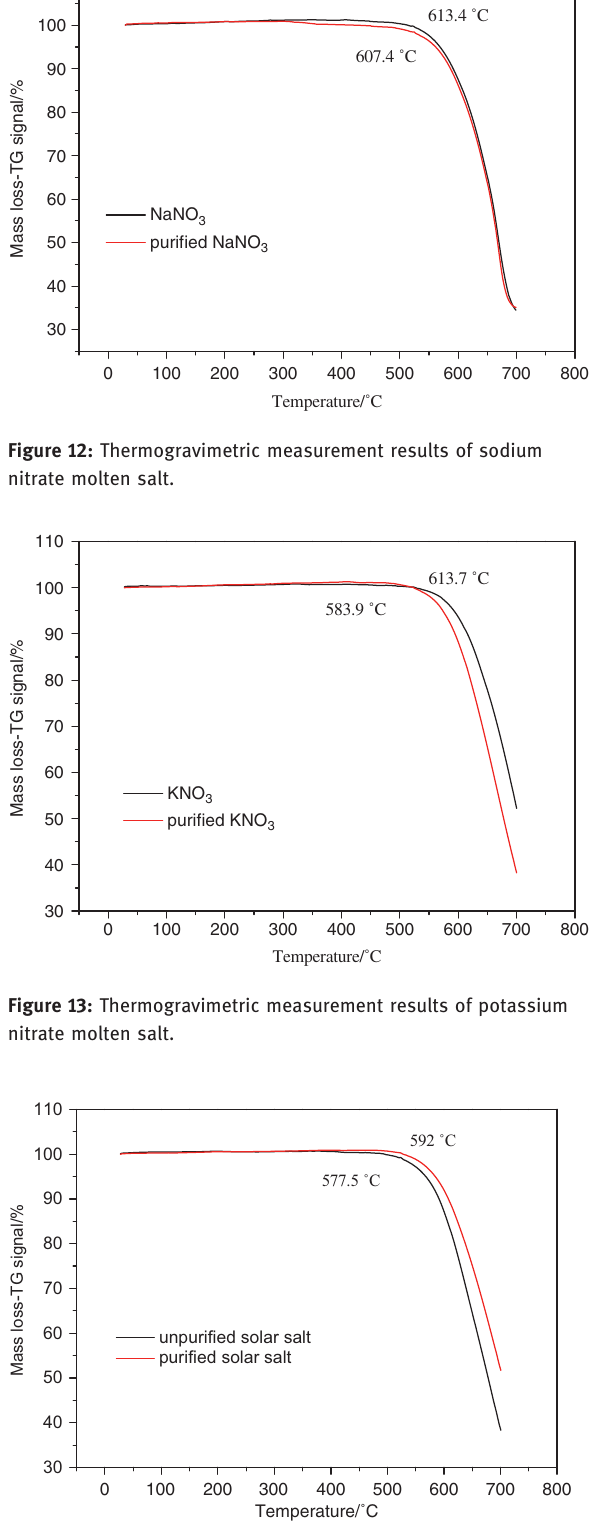
Figure 14: Thermogravimetric measurement results of Solar Salt and purified Solar